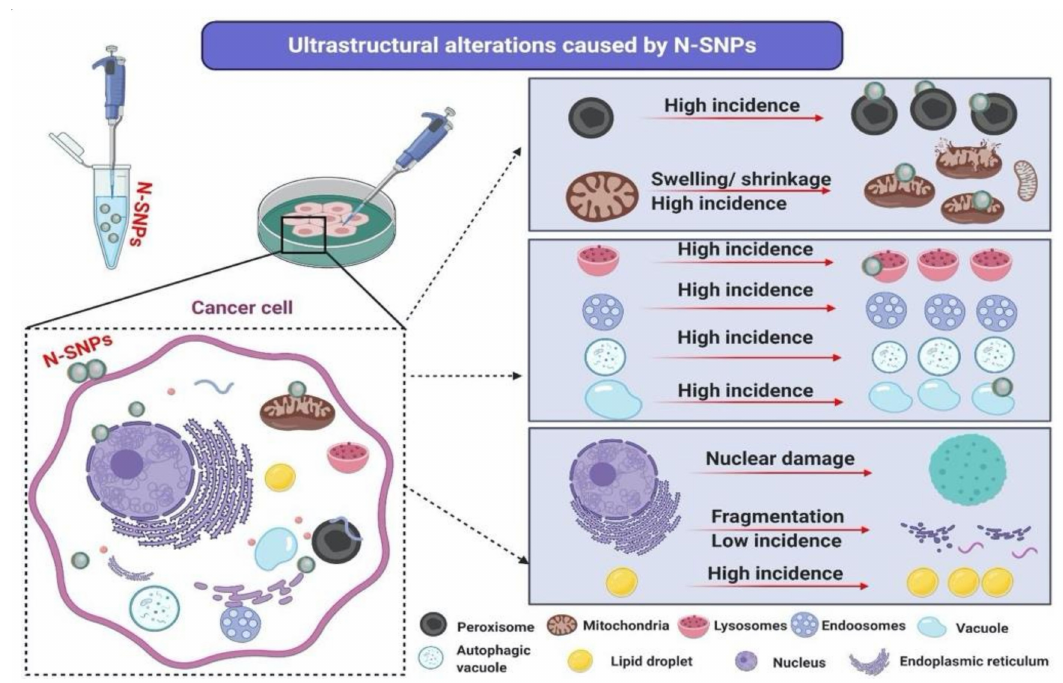
Figure 5. Ultrastructural alterations in cancer cells caused by N-SNPs.